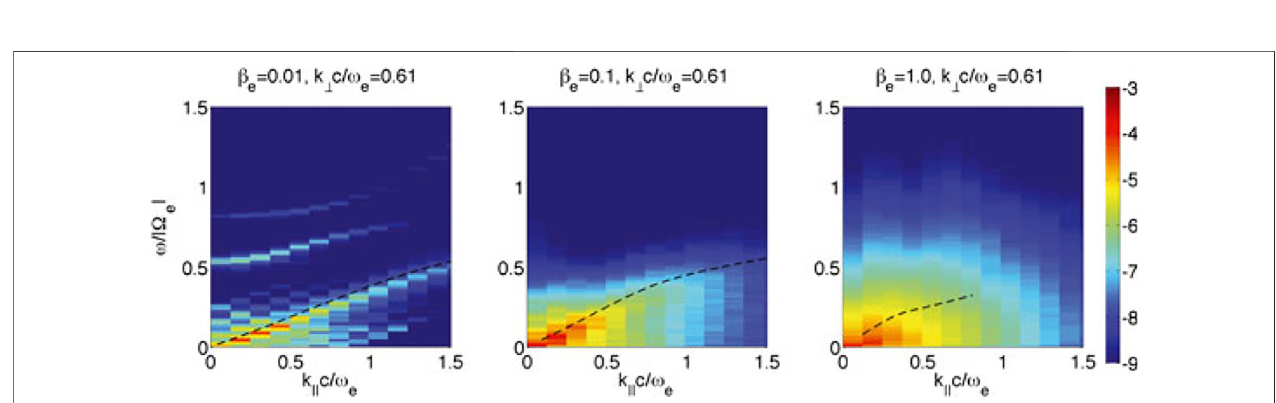
FIGURE 3 | Energy spectrum in the domain of frequency and parallel wavenumber to the mean magnetic fi eld computed over the full time evolution of PIC simulation using three different values electron beta: 0.01 (left), 0.1 (middle), and 1 (right). From Chang et al. [67].